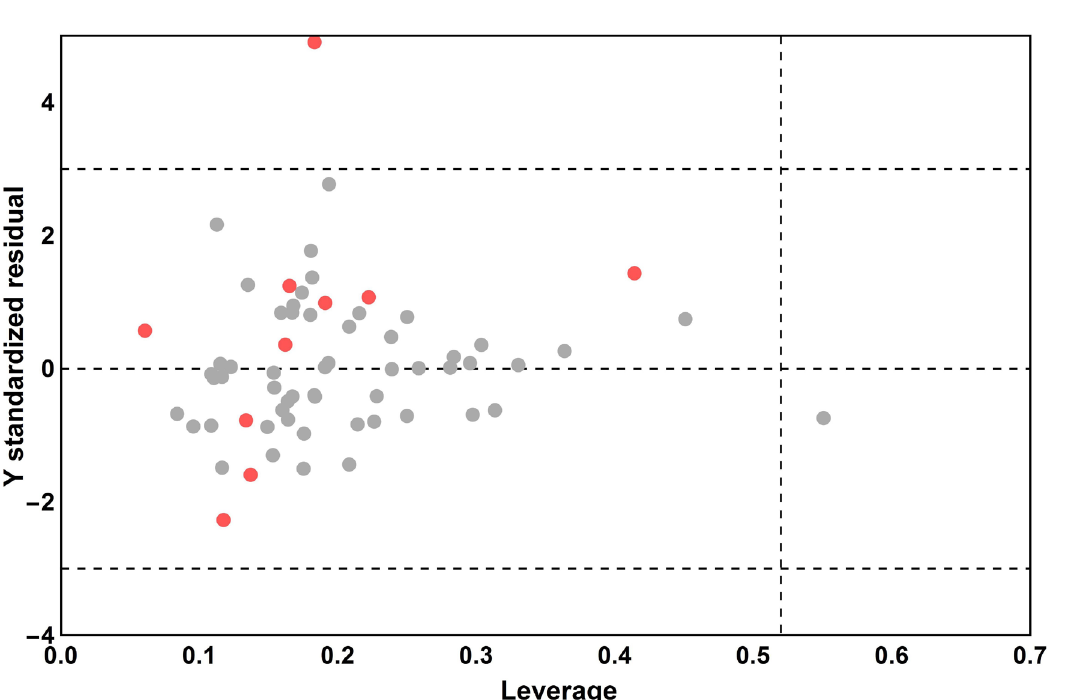
FIGURE 4 - Evaluation of applicability domain using William plots for PCM model. Internal and external set compounds are indicated by gray and red circles,